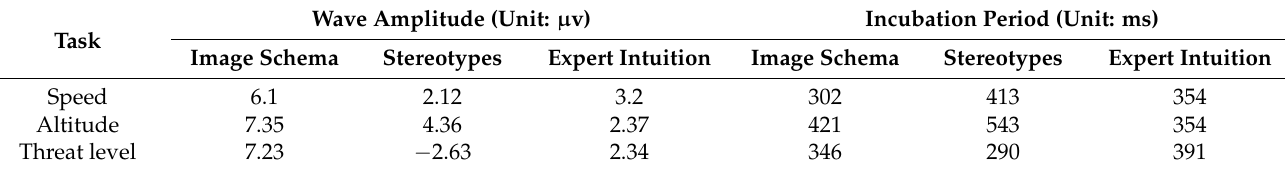
Table 7. P300 amplitude and latency for different